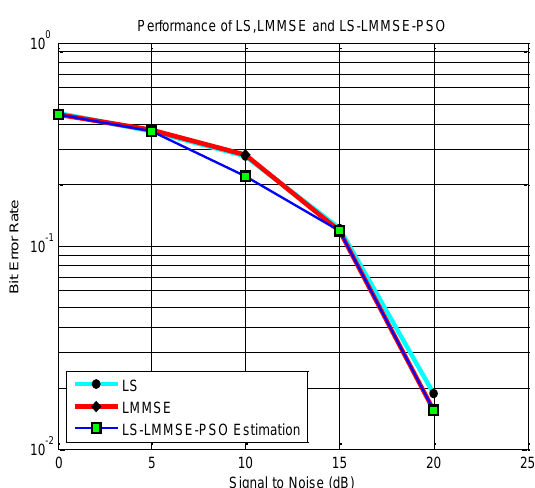
Figure 10: BER v/s SNR at Doppler frequency – 40 Hz